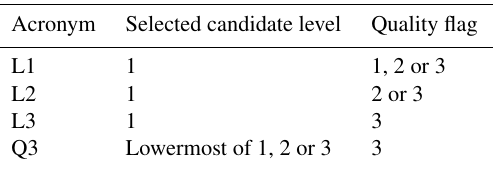
Table 2. Overview over different approaches to determine MLH from BL-VIEW: the conditions with respect to the quality flag and the number of the candidate